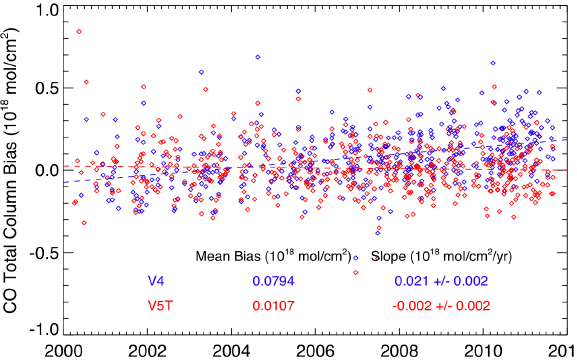
Figure 1. Time series of MOPITT V4 and V5T retrieval bias for total column CO Fig. 1. Time series of MOPITT V4 and V5T retrieval bias for to- determined from valida?on results using in situ CO profiles from NOAA sites (listed in text). Retrieval bias sta?s?cs (including long-­‐term driI) for individual sites are consistent tal column CO determined from validation results using in situ CO with the overall sta?s?cs, i.e., no clear geographical dependence is observed in the profiles from NOAA sites (listed in text). Retrieval bias statistics valida?on results. (including long-term drift) for individual sites are consistent with the overall statistics, i.e., no clear geographical dependence is ob- served in the validation